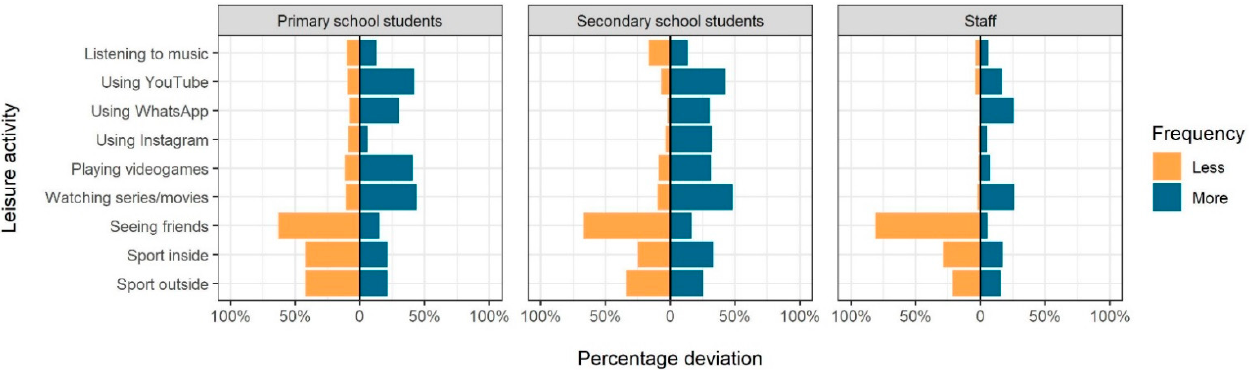
Figure 1. Deviations of time spent on leisure activities within the preceding 14 days compared to pre-pandemic times. Note: missing values to 100% reflect no change of activities .